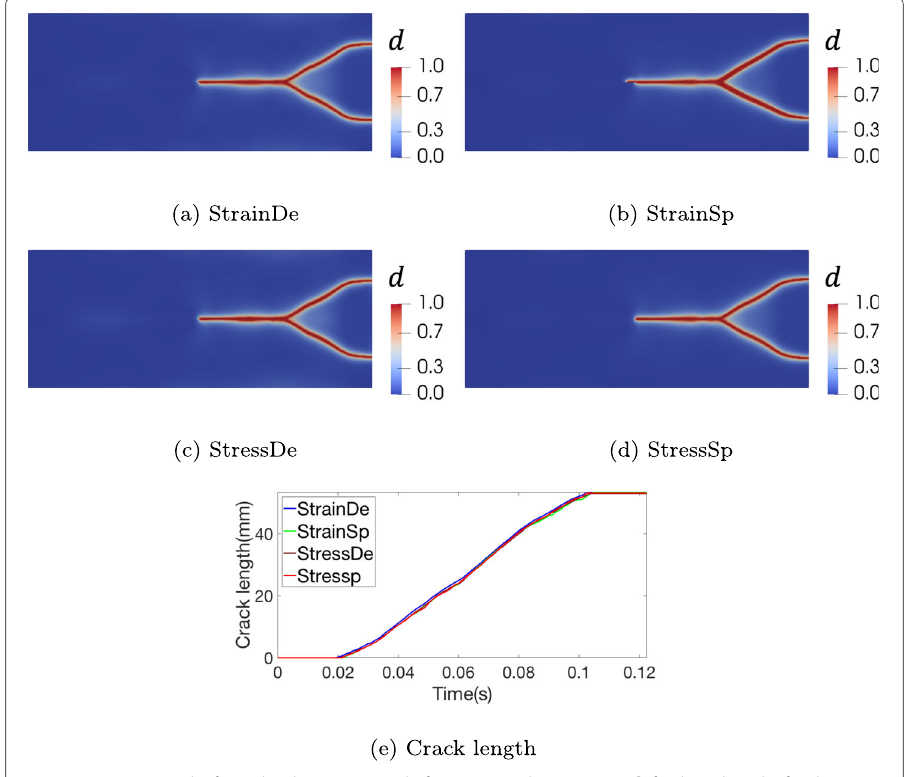
Fig. 15 Fracture results from the dynamics tensile fracture simulations: ( a ) - ( d ) final crack paths for the strain deviatoric decomposition method, strain spectral method, stress deviatoric decomposition method, and stress spectral method, respectively; ( e ) the crack length evolution for the four